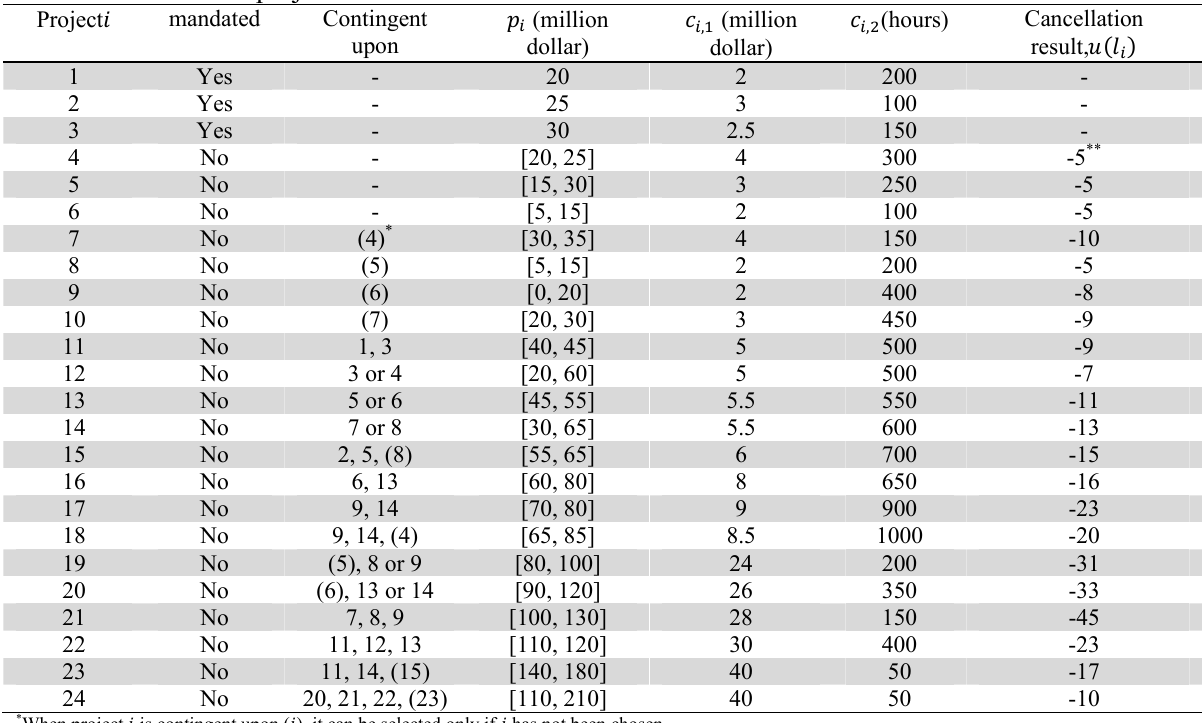
Information for each project